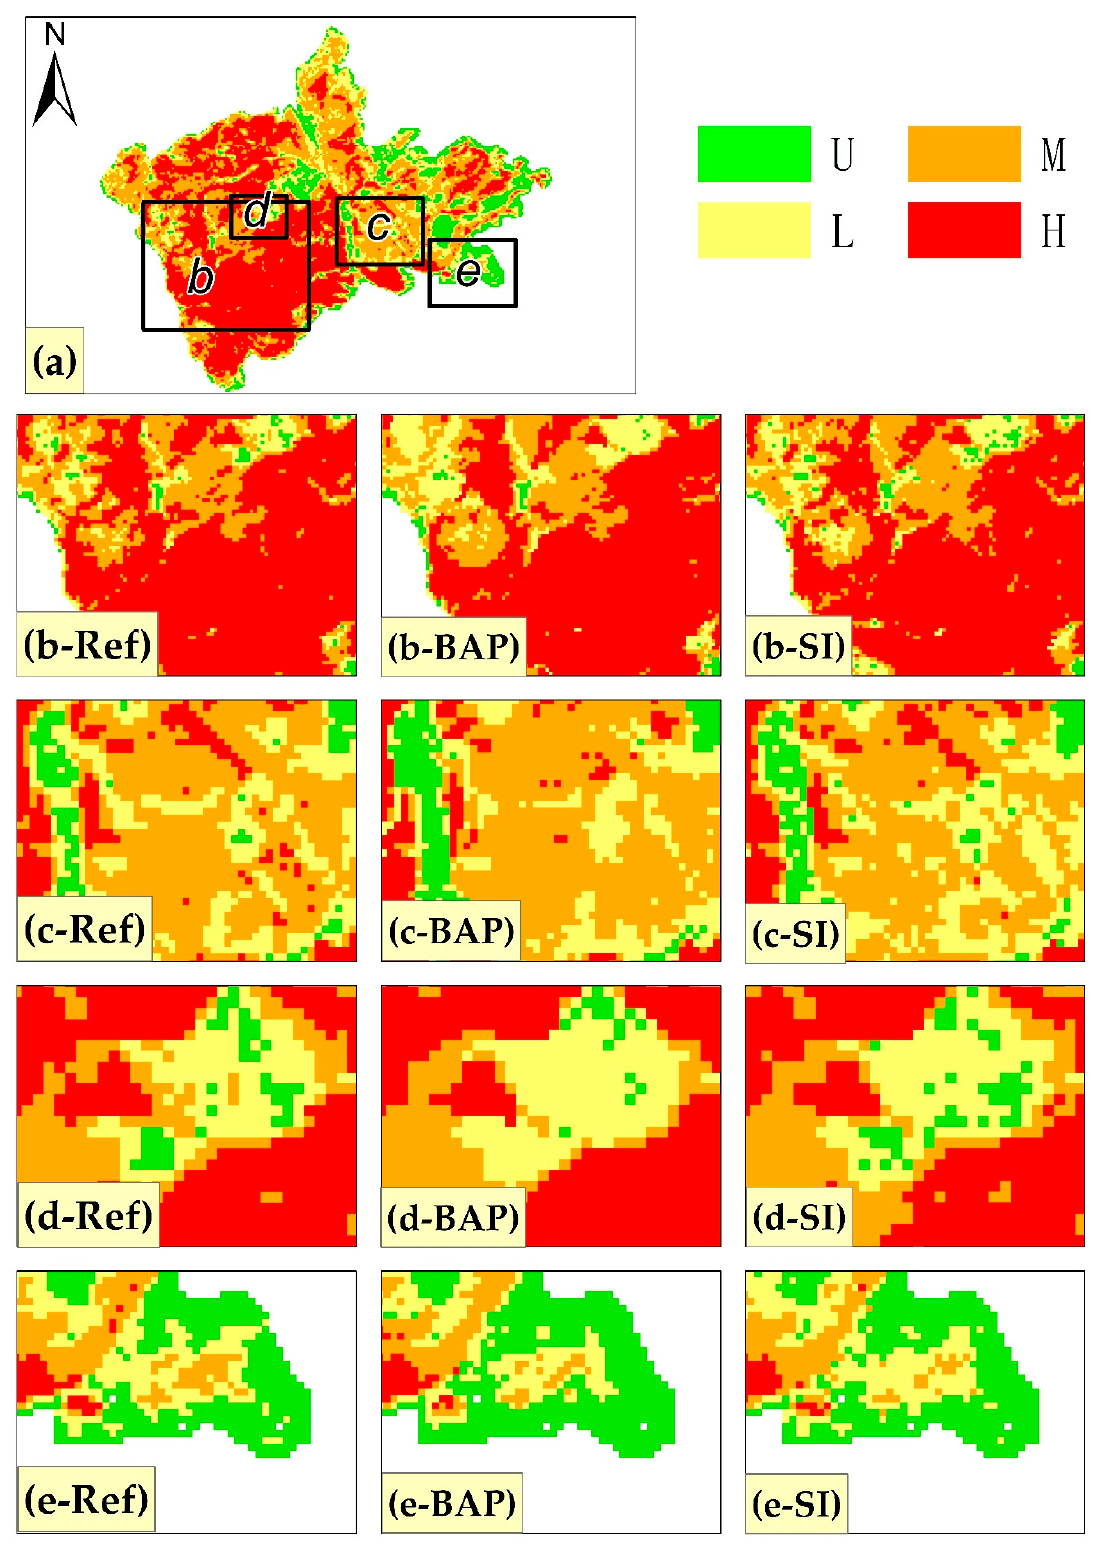
Figure 9. Detailed display of BO fire mapping results: ( a ) fire severity reference map; ( b ) Detailed display of H class; ( c ) M class; ( d ) L class; ( e ) U class. Ref: reference map; BAP: Fire severity mapping generated by BAP method; SI: Fire severity mapping generated by SI method.